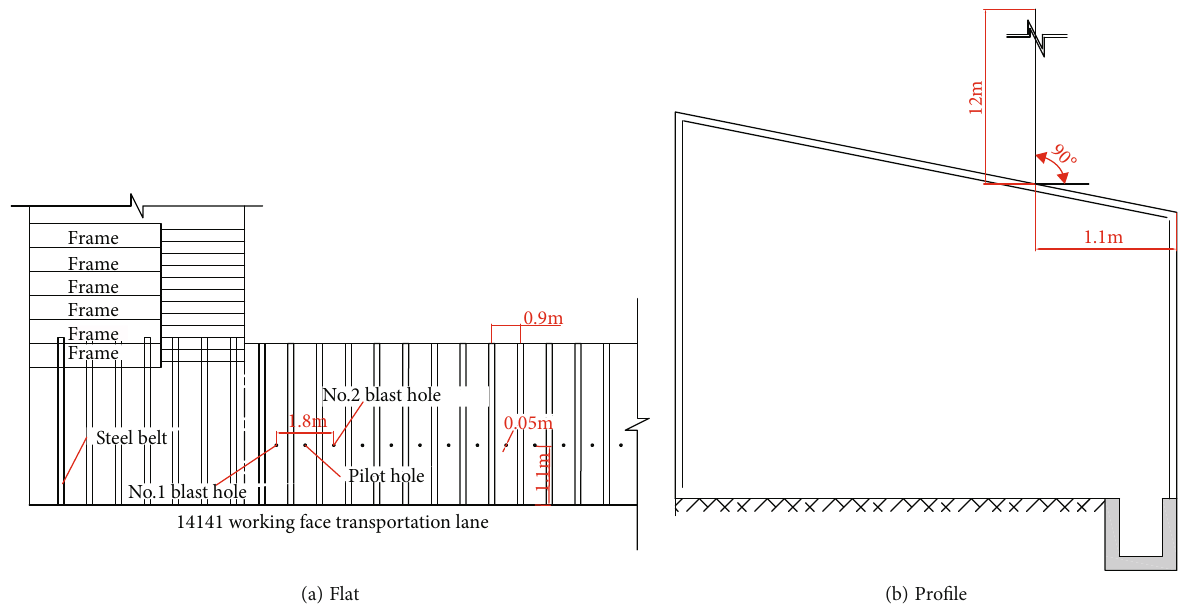
Figure 12: Arrangement of presplitting blasting holes in transportation lane of 14141 working face.